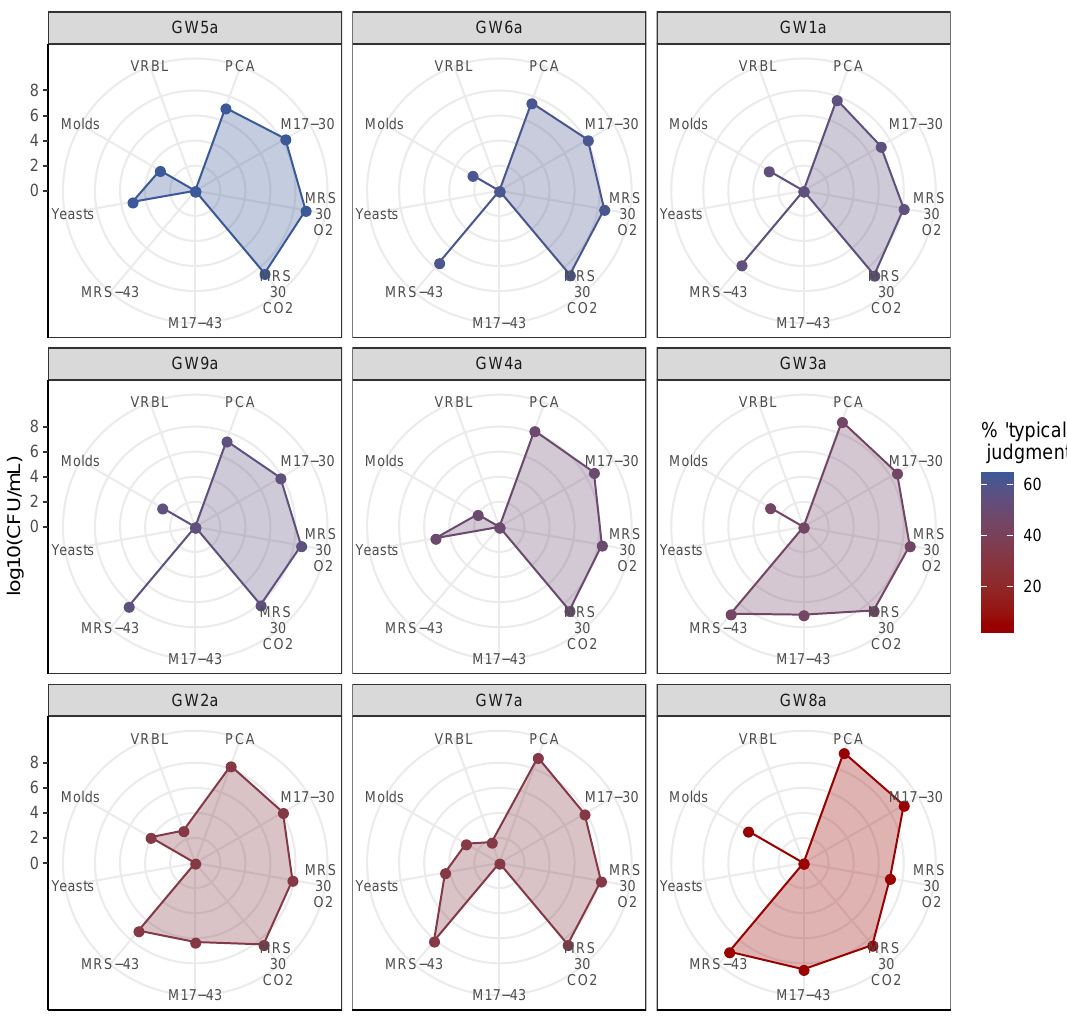
Figure 4. Radar graph of microbial counts. Each radar axis shows the enumeration results expressed in log CFU/mL for one medium. The name of each medium is followed if necessary by the incubation temperature (30 ◦ C or 43 ◦ C), and the aerobic (O 2 ) or anaerobic (CO 2 ) conditions applied. Yeasts and molds were cultured on OGA medium. All radar axes had the same scale. Samples are ordered and colored according to the typicality score obtained during the first sensory